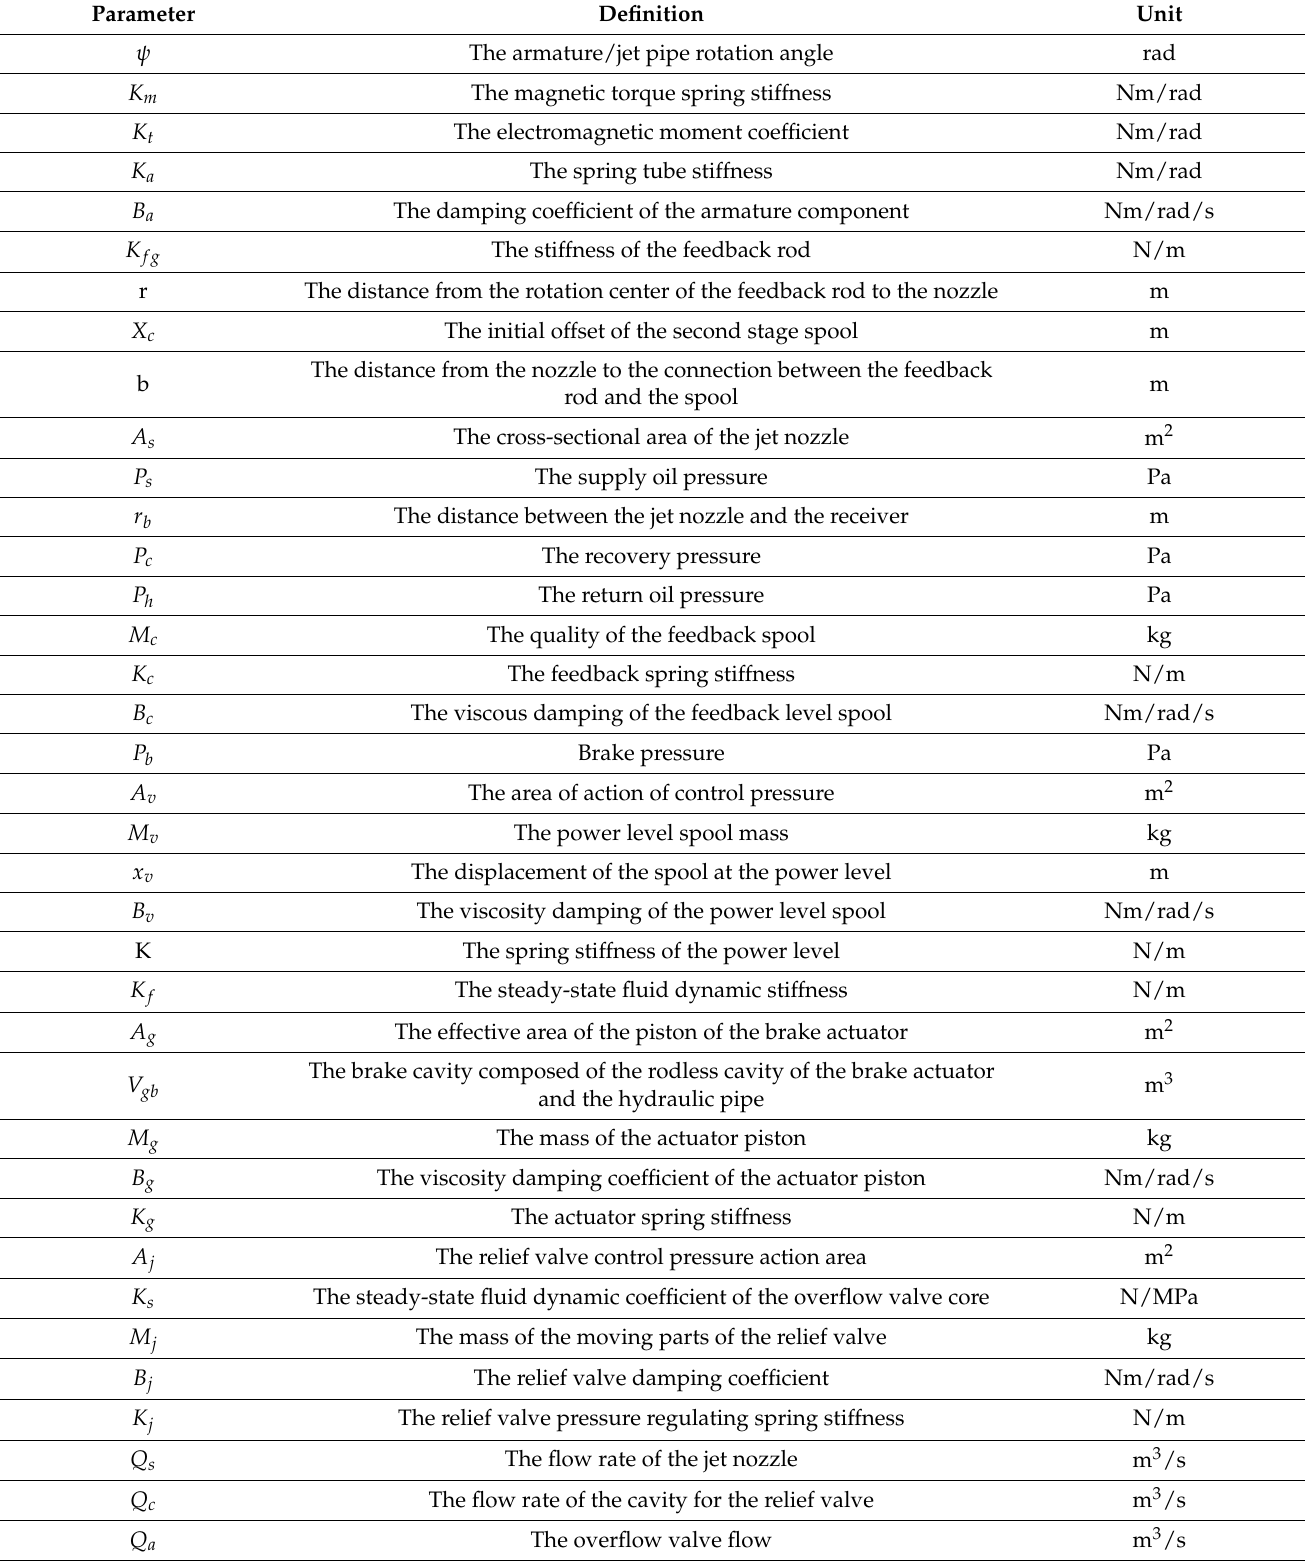
Table 1. The parameters of Figure